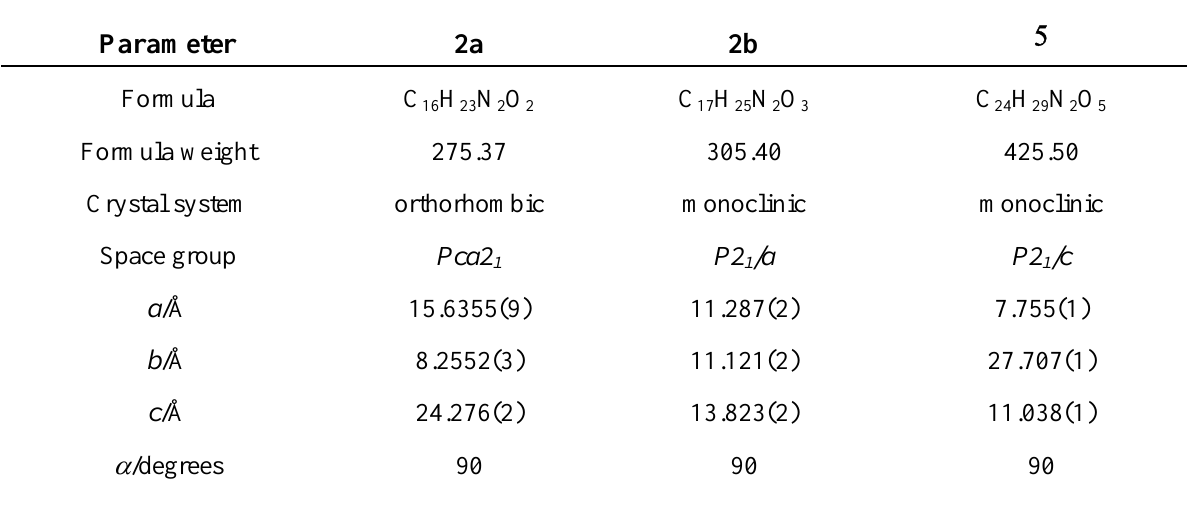
Table 1. Summary of crystal data for 2a , 2b and